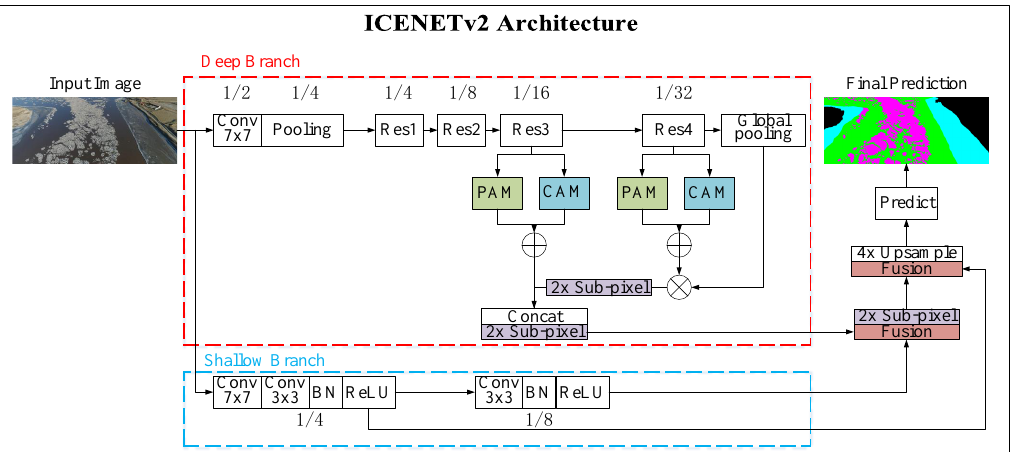
Figure 4. The architecture of ICENETv2. It mainly contains two branches: The deep branch in the red dashed box and the shallow branch in the blue dashed box. Res1, Res2, Res3, and Res4 are four original residual blocks from residual blocks in ResNet-101. ‘CAM’ and ‘PAM’ is the channel attention module and the position attention module, respectively. The notation ‘Sub-pixel’ means sub-pixel up-sampling module. ’Fusion’ is the fusion module. The fractions in the two branches are the ratios of the feature map size to the resolution of the input.